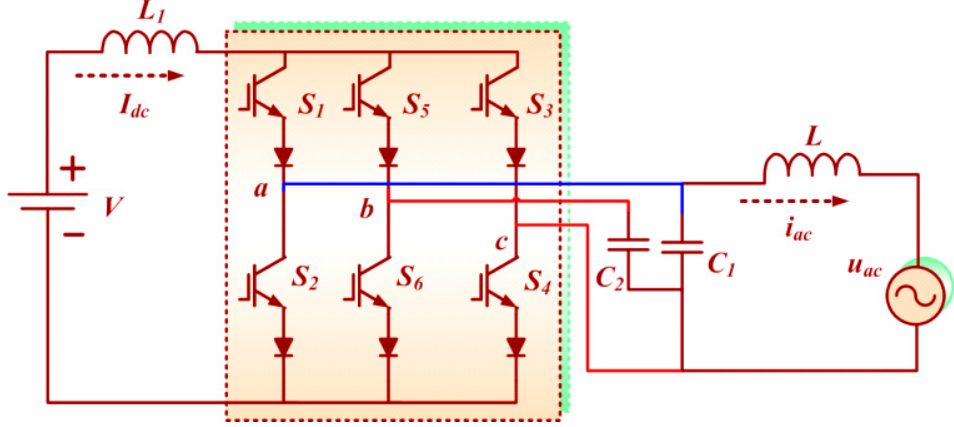
Figure 9. Power decoupling solution in [35].